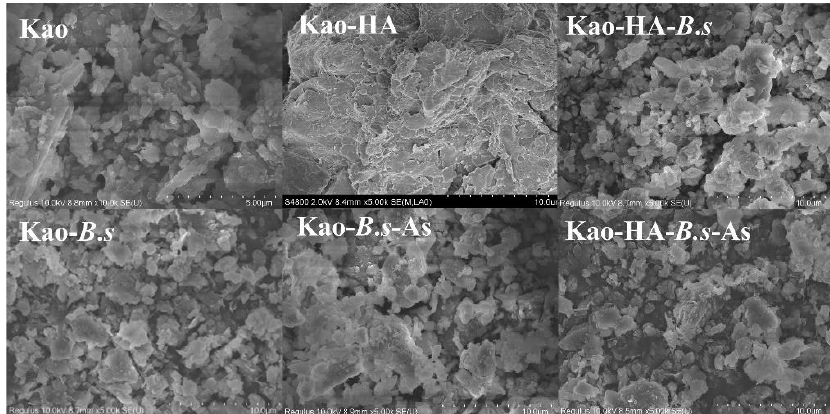
Figure 7. SEM images of composites before and after As(V) adsorption.